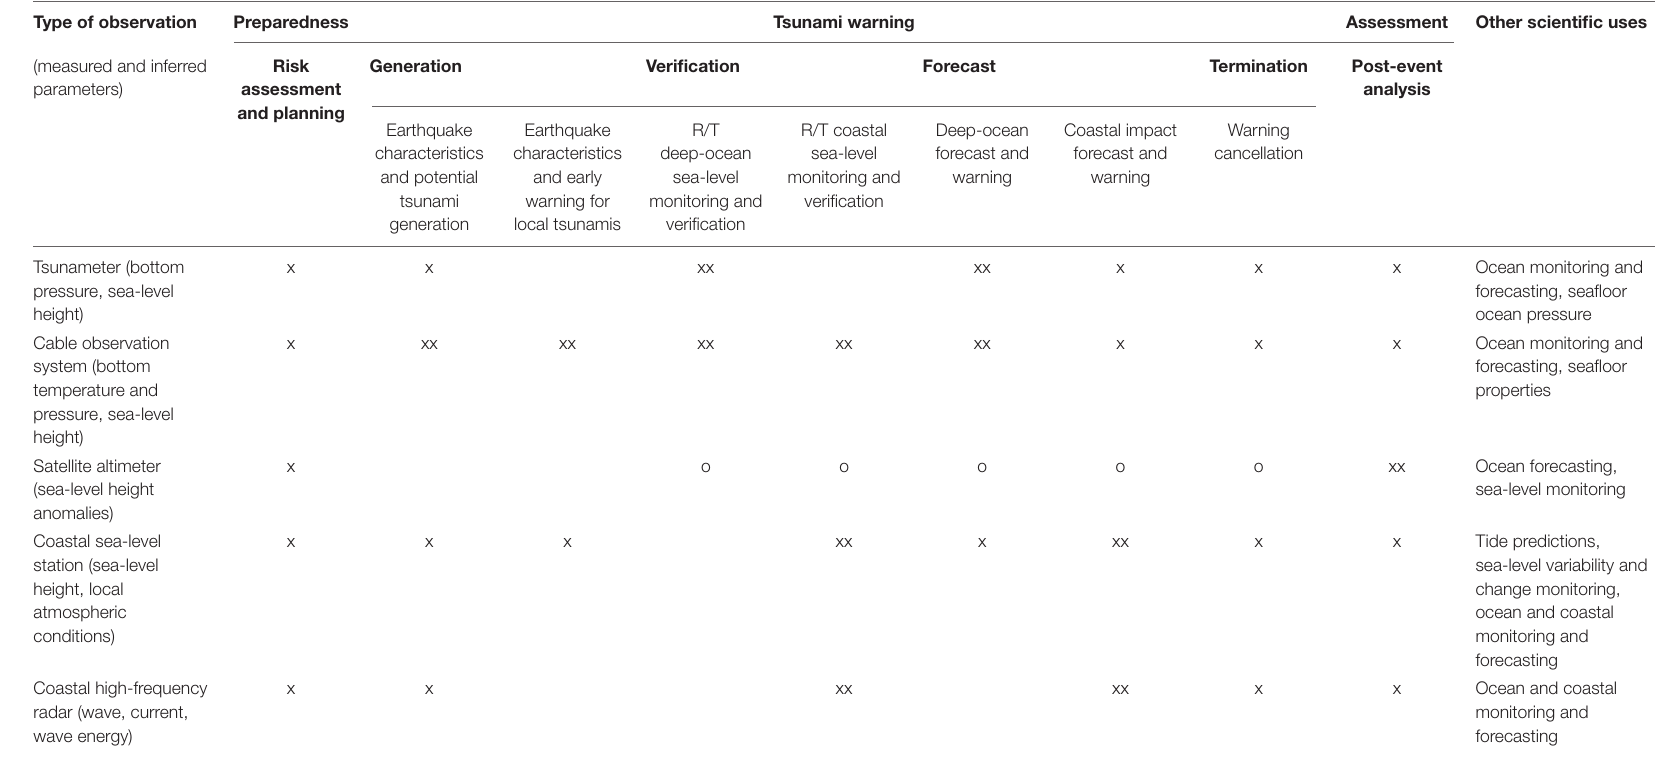
TABLE 1B | Observation utility matrix: Oceanographic measurements. Type of observation (measured and inferred parameters)